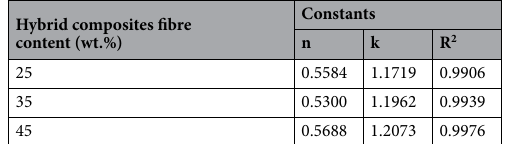
Hybrid composites fibre content (wt.%)